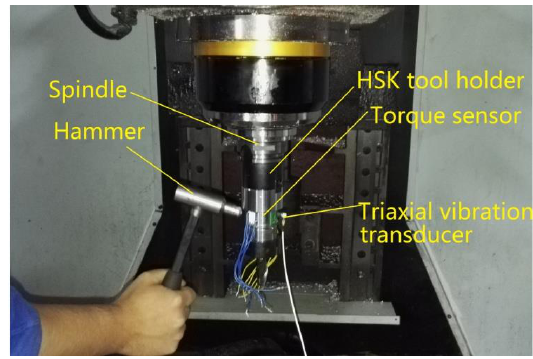
Figure 9. Experimental setup of the modal impact tests.